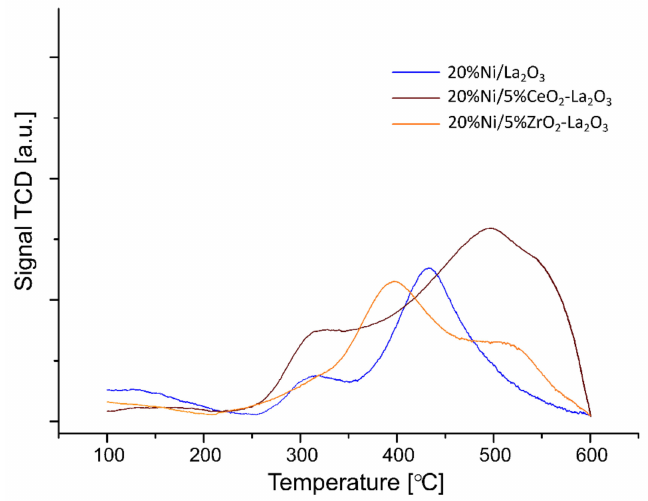
Figure 4. The temperature programmed desorption of ammonia profiles recorded for 20% Ni/La 2 O 3 , 20% Ni/5% CeO 2 –La 2 O 3 and 20% Ni/5% ZrO 2 –La 2 O 3 catalysts reduced in hydrogen atmosphere for 1 h at 500 ◦